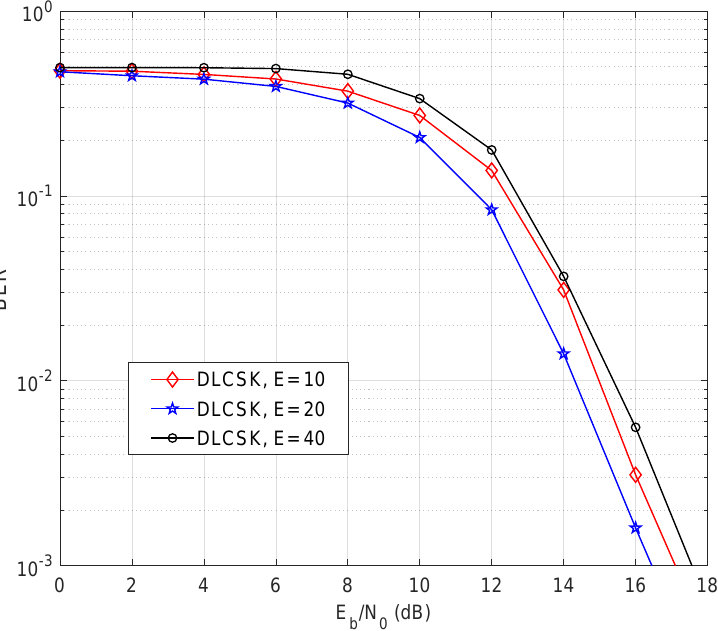
Figure 9. BER of SISO DLCSK under AWGN channel, for β = 50 and different numbers of training epochs (E).